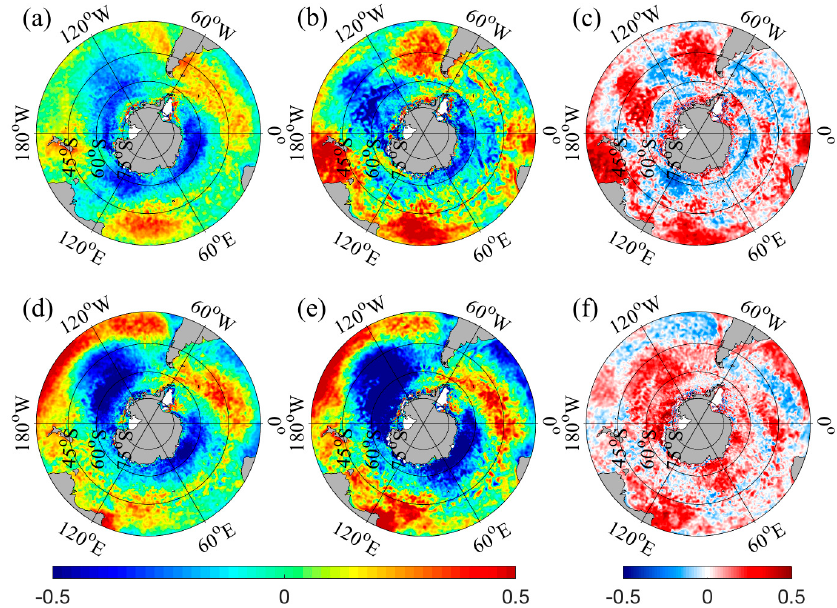
Figure 4. Monthly mean sea surface temperature (SST) standardized anomalies during positive Antarctic Oscillation (AAO) ( a ) and Southern Oscillation (SO) ( d ) months and ( b , e ) are standardized temperature anomalies during positive AAO and SO years respectively. ( c , f ) are the absolute value of yearly averaged anomalies minus the absolute value of monthly averaged anomalies. Red (blue) depicts yearly averages are greater (weaker) than monthly. In each instance, a positive index is defined as greater than 0.5.